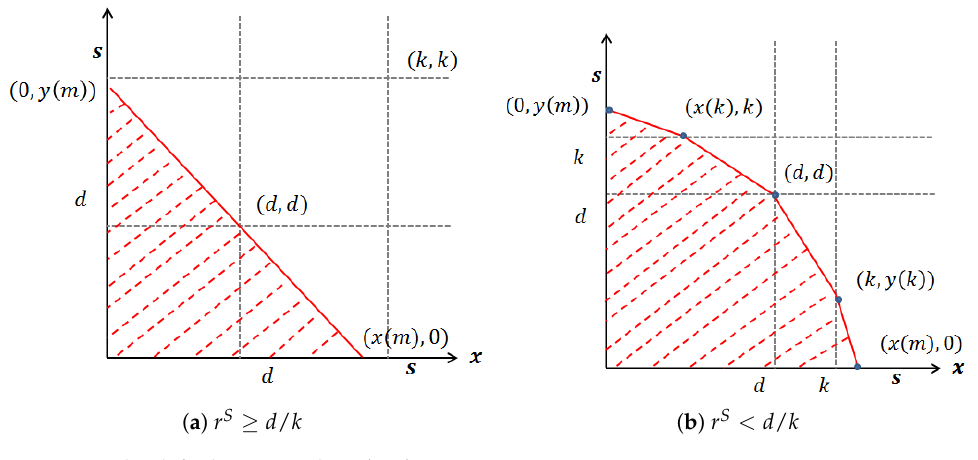
Figure A5. The default region when d < k